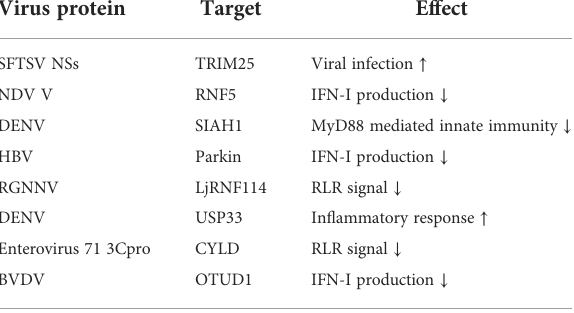
TABLE 4 Hijack the host's E3s/DUBs. Virus protein Target